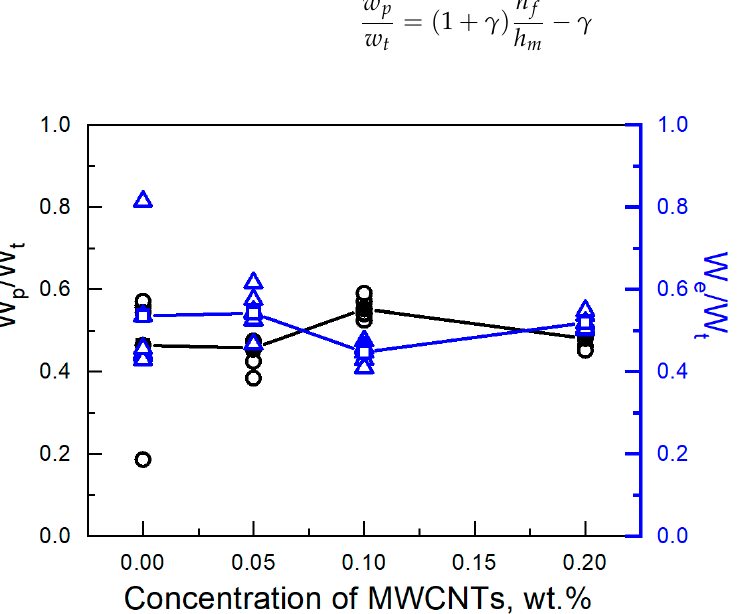
Figure 7. Left axes: Dependence of ratio plastic work to the total work of deformation of composite HA/MWCNTs vs. concentration of MWCNTs (black circle—for indentation tests, and black—square average value). Right axes: Dependence of ratio elastic (reversible) work to the total work of deformation of composite HA/MWCNTs vs. concentration of MWCNTs (blue open triangle—for indentation tests, and blue open square—average